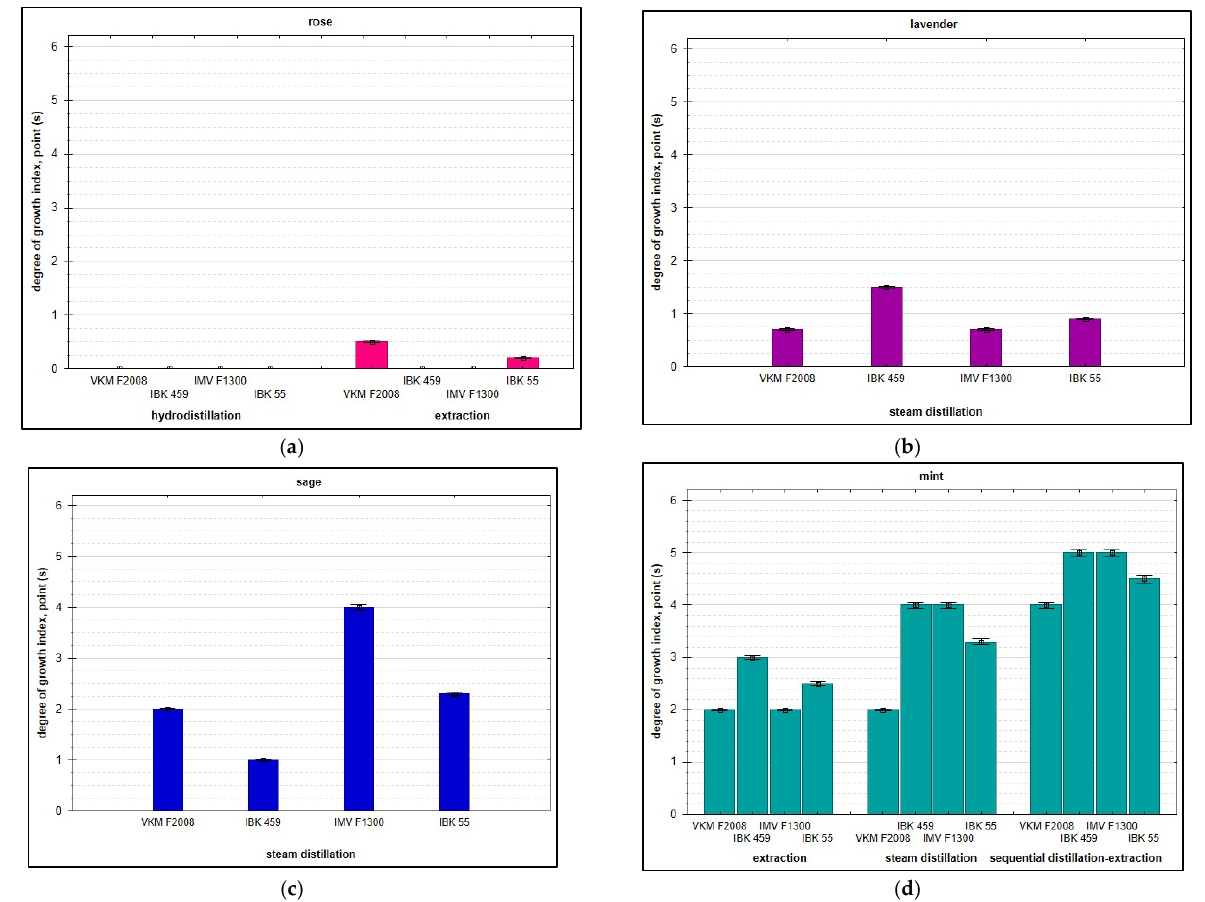
Figure 1. Degree of mycelium development (ordinate axis—6-point evaluation) of A. bisporus , P. ostreatus, and L. edodes on wastes from processing of floral and herbaceous essential oil raw materials at an air humidity of 50%: rose ( a ); lavender ( b ); sage ( c ); and mint ( d ). The studied strains of basidiomycetes in deep culture also accumulated large amounts of biomass, for example, the biomass of P. ostreatus strain IMV F1300 reached 16 g per 1 kg of the substrate within 6 days. The level of accumulation of aroma-forming compounds directly depends on fungi biomass: the A. bisporus strain IBK 459 synthesized 30.0 mg/kg of essential oil within 3 days at a biomass of 2.34 g/kg and after 6 days at a biomass of 11.86 g/kg produced 41.4 mg/kg of essential oil and 262.0 mg/kg of extract. The mycelial mass of edible mushrooms preserved their flavor after drying during long-term storage (up to 10 years), as well as during cooking, in particular, by boiling for 10–15 min. A